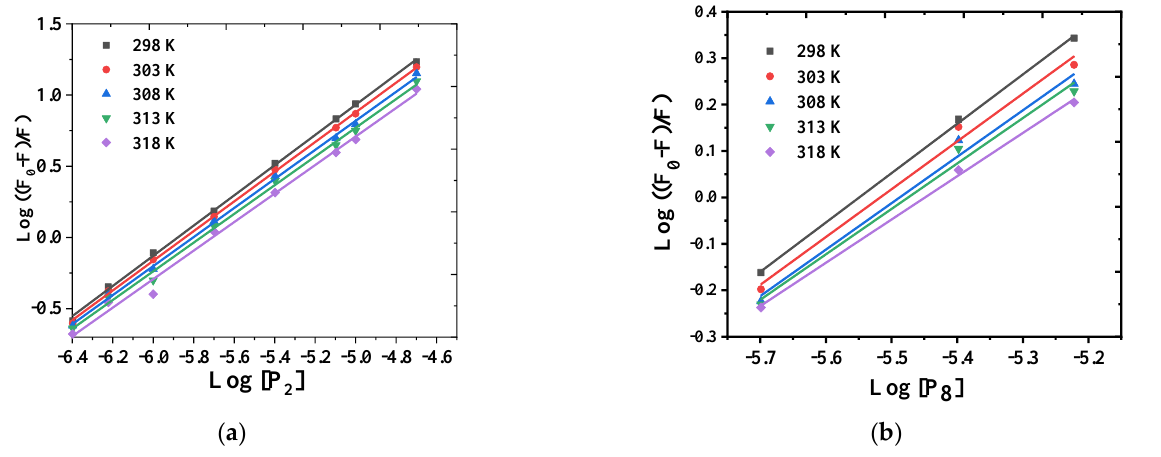
Figure 9. The effects of increasing concentrations of ( a ) chlorfenvinphos (P2) and ( b ) malathion (P8) on the luminescence intensity of the Eu (III)–(vitB1) 2 complex in methanol at different temperatures.